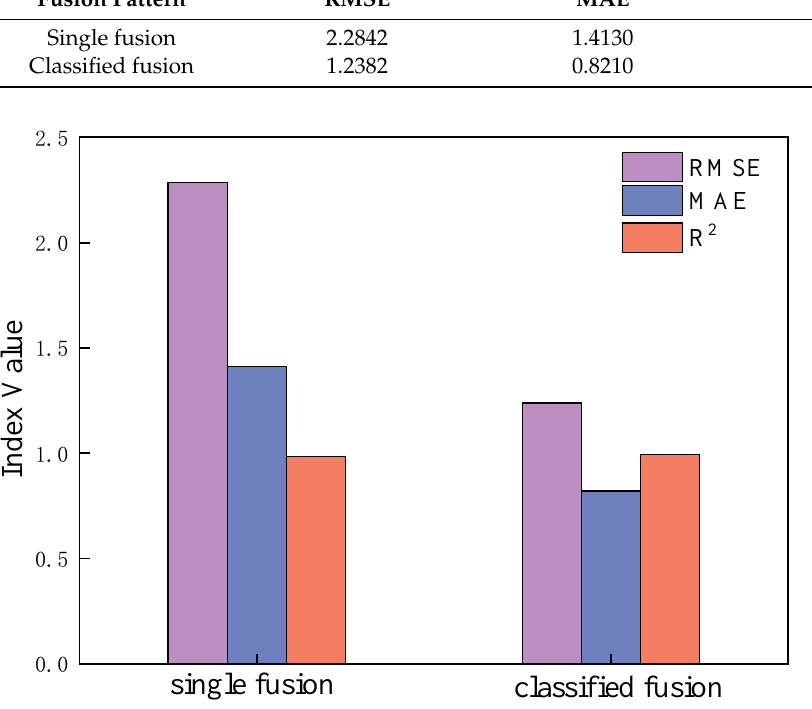
Figure 14. The chart of evaluation indexes of IPSO – LSTM in different fusion patterns.